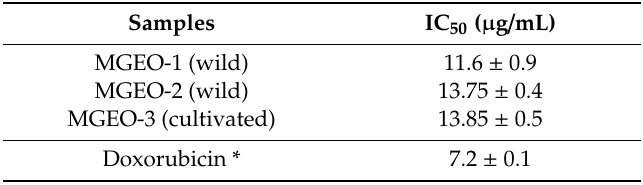
Table 6. Inducible nitric oxide synthase (iNOS) IC 50 values (mean ± SD, µ g / mL) of MGEOs 1 to 3